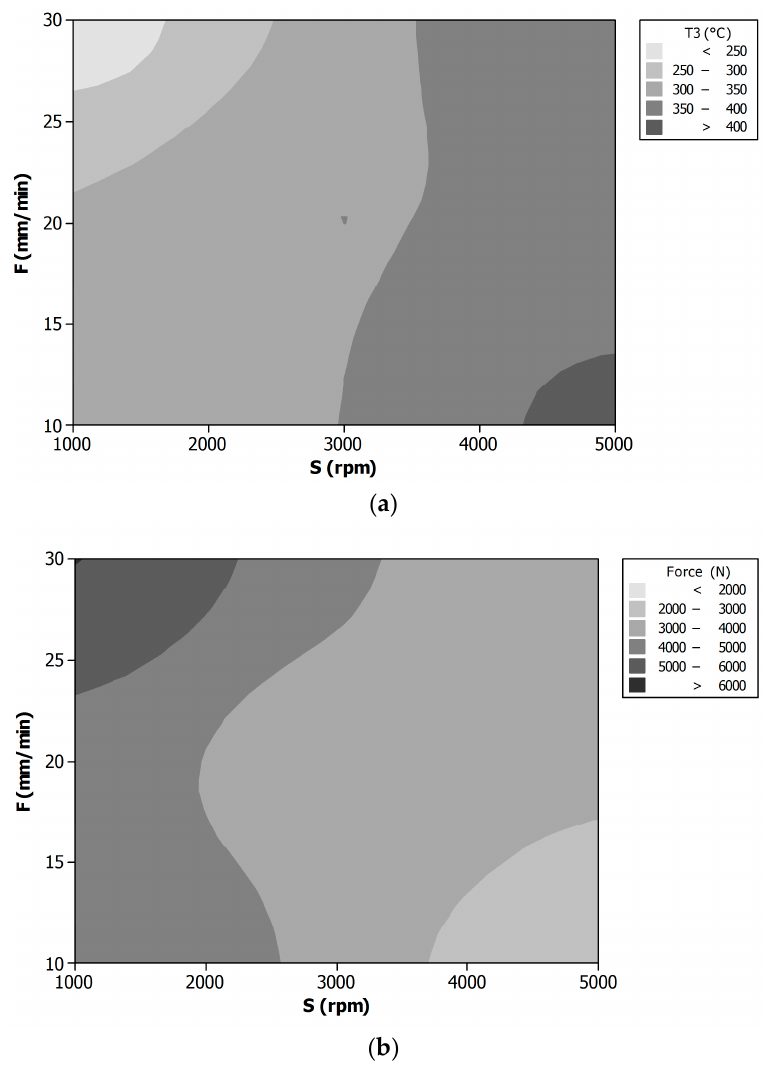
Figure 4. Contour plot of temperature T3 (7 mm from the joint axis) ( a ) and welding force ( b ) vs. tool rotational speed (S) and feed rate (F).